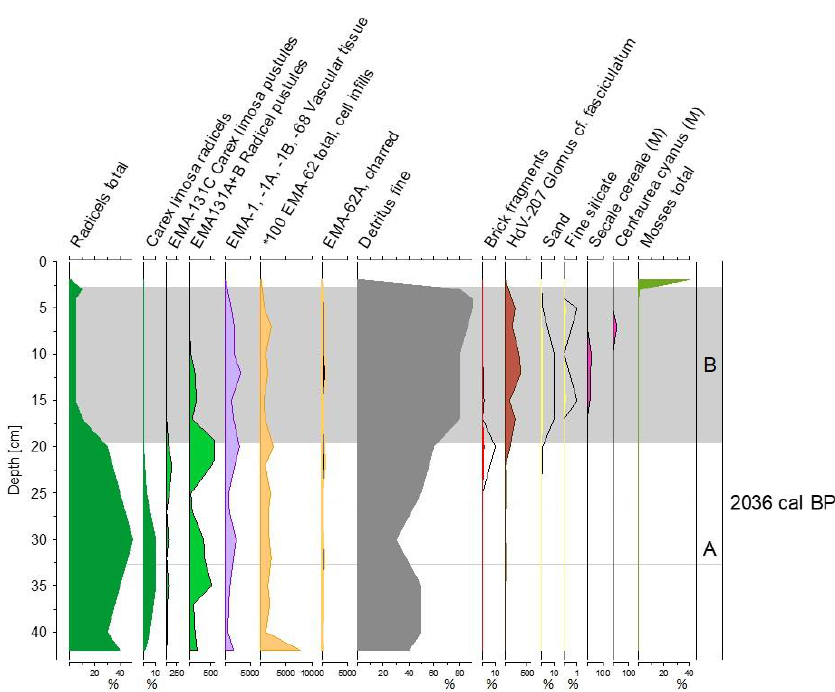
Figure 1. Selected curves of macro- and micro-remain analyses of site PD. Note the scales and units of the x-axes. Curves show percentages (%) of macro-remains as indicated or otherwise concentrations (10 1 N cm −3 ) of micro-remains.